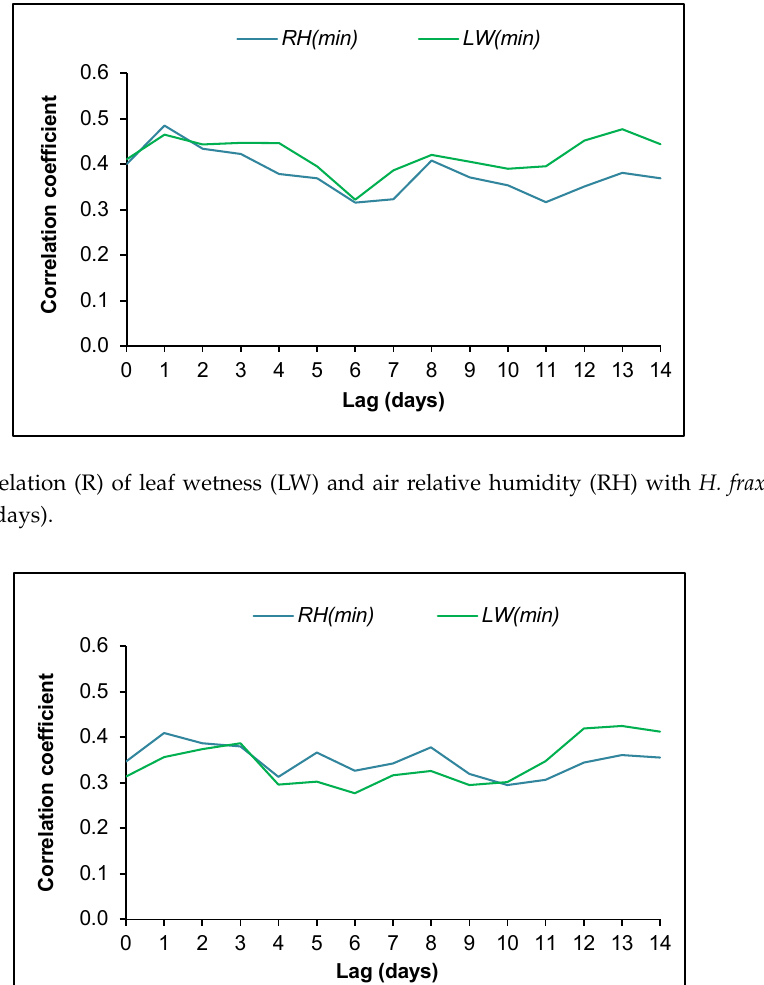
Figure 6. Correlation (R) of leaf wetness (LW) and air relative humidity (RH) with H. albidus air inoculum lag (days).